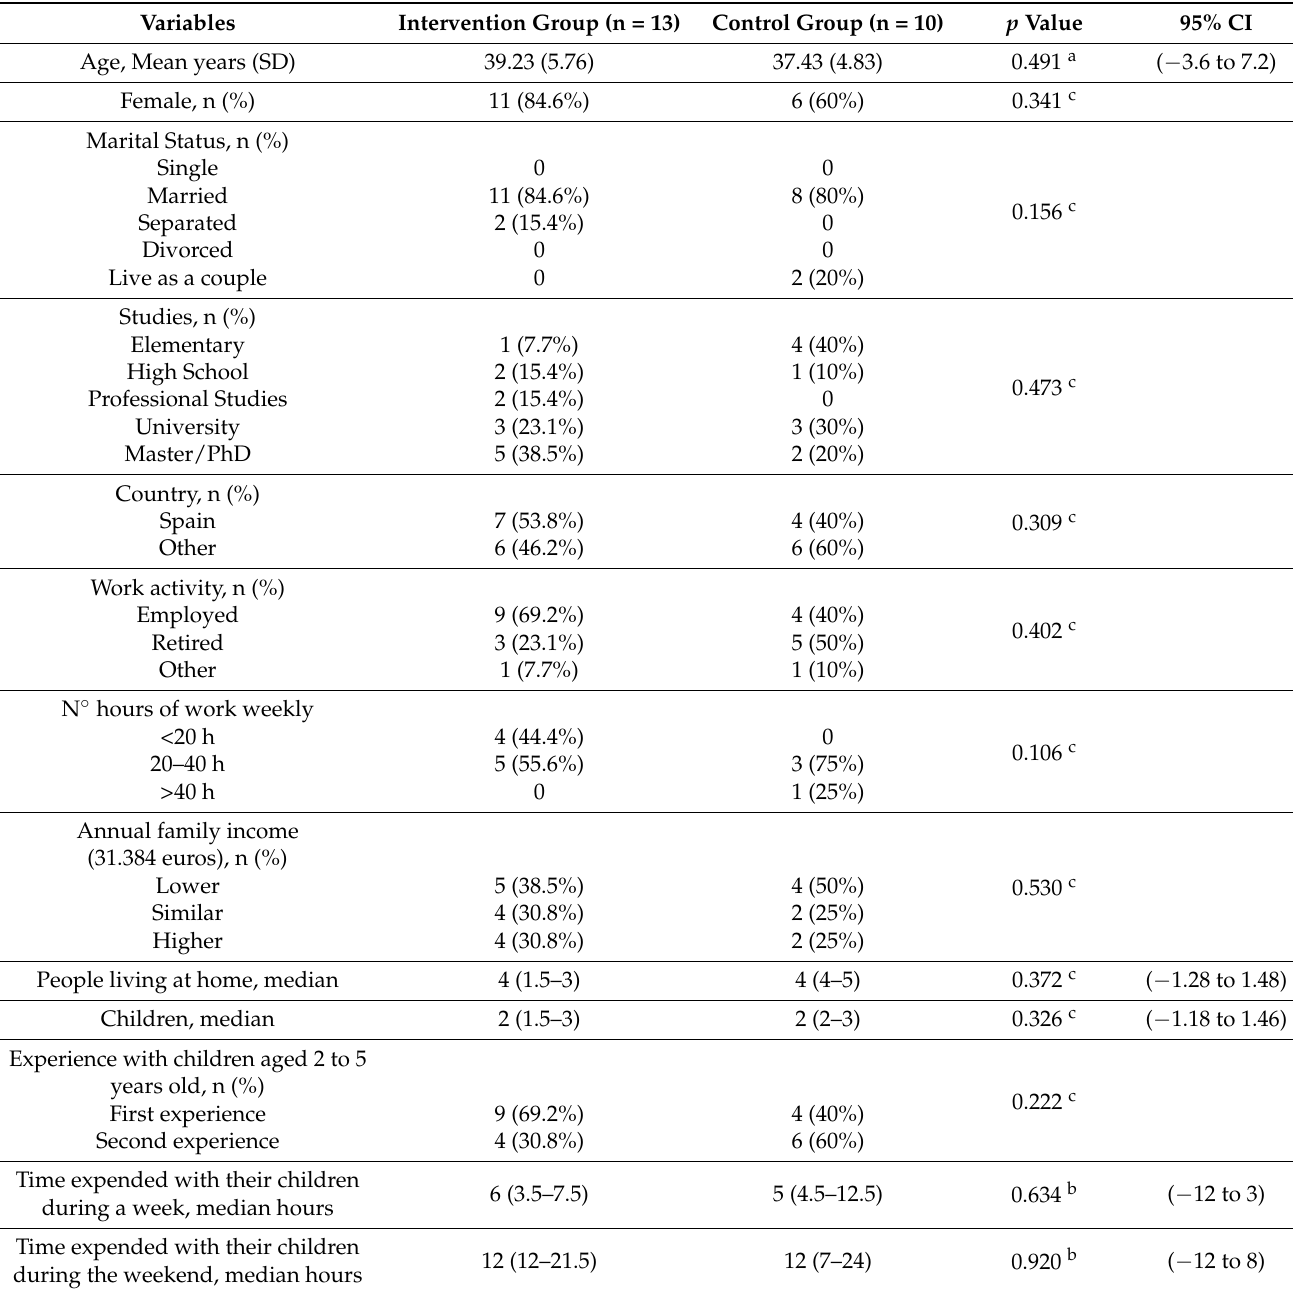
Table 1. Participants socio-demographic